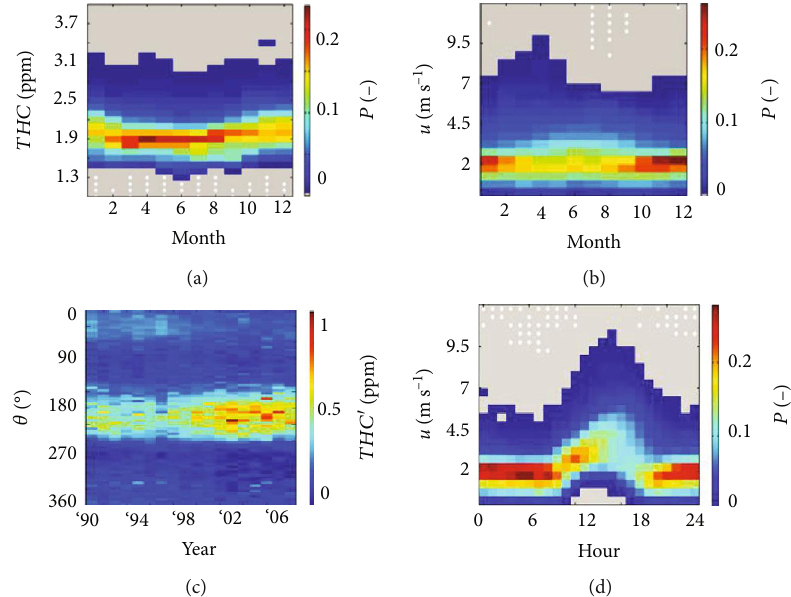
Figure 17: Normalized probability histogram ( P ) of (a) monthly averaged total hydrocarbon ( THC ) concentration for West Campus Station for 1991-2009 for (b) wind speed ( u ) showing seasonal trends. (c) THC anomaly ( THC' ) relative to non-seep directions versus wind direction ( θ ), and (d) P of u relative to hour showing diurnal trend. From Bradley et al. ([53], Figs. 4 and